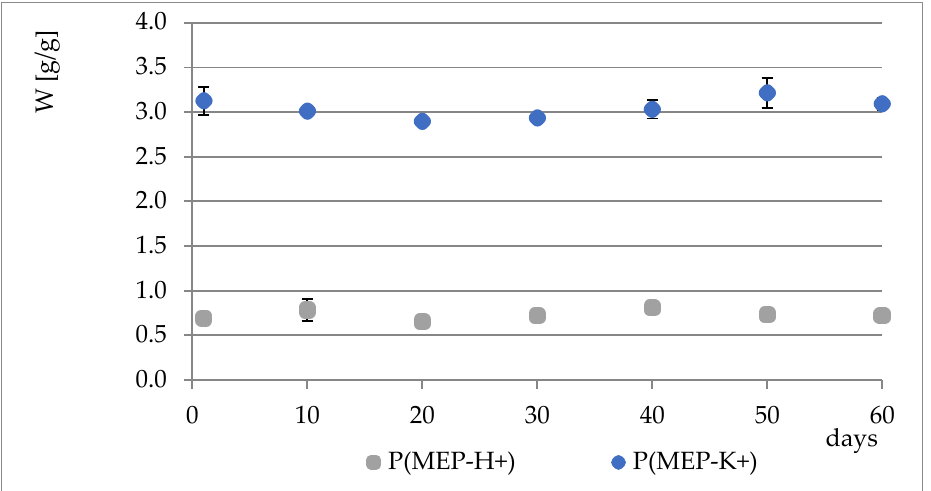
Figure 5. Phosphorus content changes in PMEP over a two-month period.